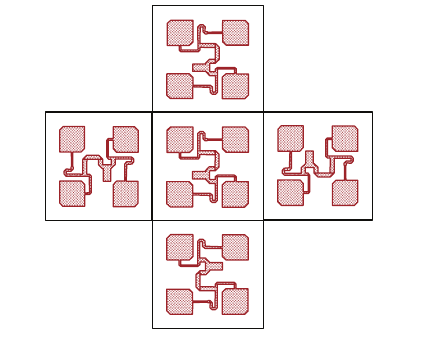
Figure 6: Measured power density distribution.